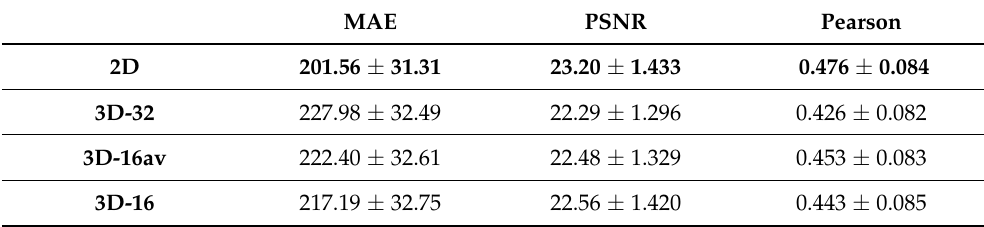
Table 21. Pelvis dataset Bone with Residual-net. Mean Absolute Error, PSNR and Pearson coefficient from Residual-net using different convolutions and reconstructions in the Pelvis data set within the bone.